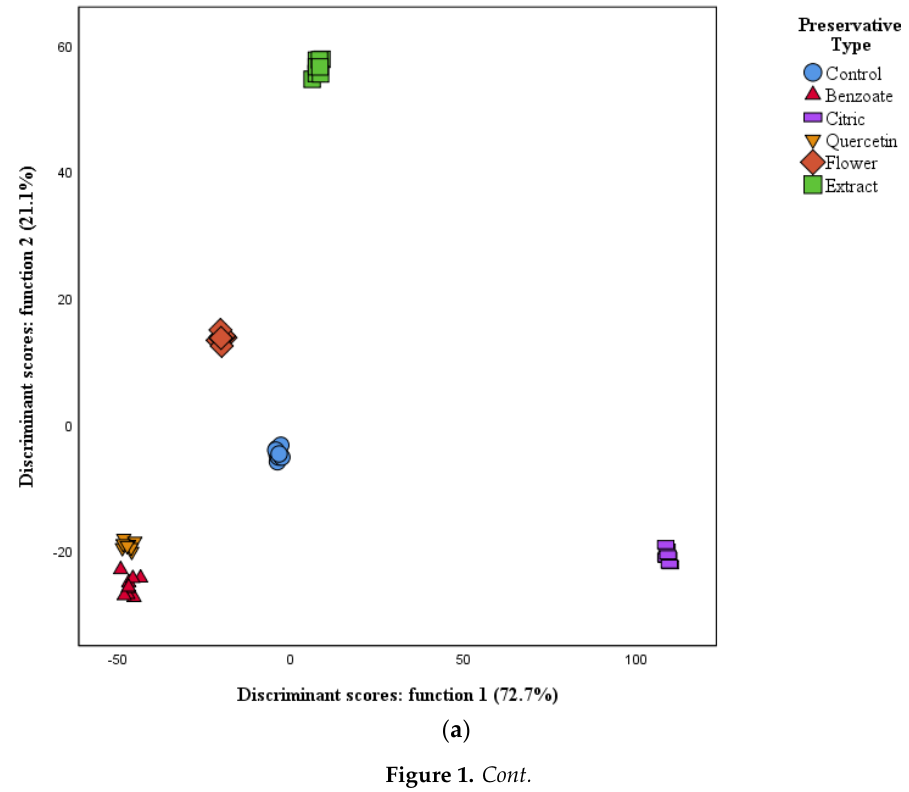
( b ) Figure 1. Spatial distribution of TP ( a ) and ST ( b ) markers following the distribution set by the canonical discriminant functions coefficients. Function 1 accounted for 71.9% of the variation, while function 2 accounted for 28.1%. Together, both functions covered 100% of the variation. 3.6. Microbiological Analysis The antimicrobial capacity of a food preservative is of paramount importance due to much spoilage of foods being of microbial origin. Considering this, aliquots of the different nutraceutical formulations with the different preservatives were contaminated with various microorganisms